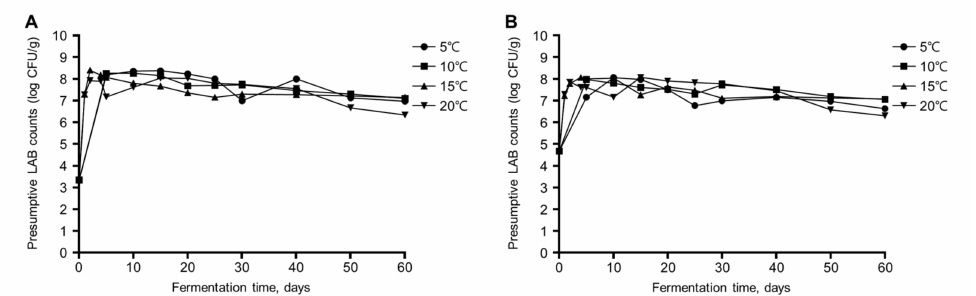
Figure 2. Changes in presumptive LAB counts (log CFU/g) of gajami-sikhae samples during fer- mentation at different fermentation temperatures: ( A ) presumptive LAB count incubated at 20 ◦ C; ( B ) presumptive LAB count incubated at 30 ◦ C.